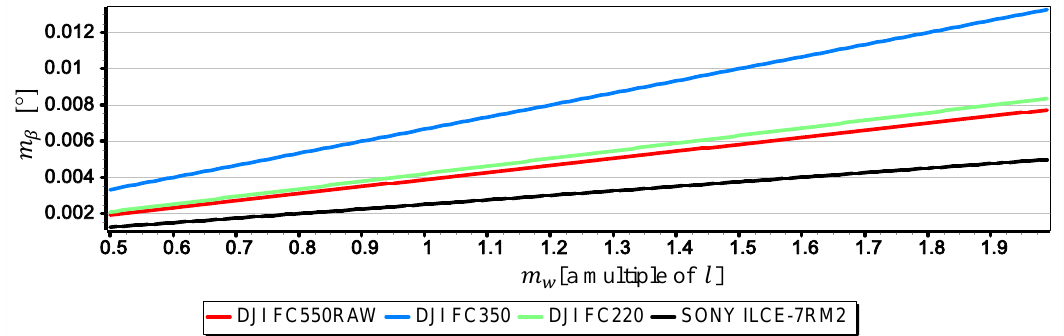
Figure 23. Mean error of measurement m β as a function of m w for β = 15 ◦ (only the second component Figure 23. Mean error of measurement 𝑚 𝛽 as a function of 𝑚 𝑤 for 𝛽 = 15° (only the second Figure 23. Mean error of measurement 𝑚 𝛽 as a function of 𝑚 𝑤 for 𝛽 = 15° (only the second of the Formula (3) was used in the component of the Formula (3) was used in the calculations). Figure 23. Mean error of measurement 𝑚 𝛽 as a function of 𝑚 𝑤 for 𝛽 = 15° (only the second component of the Formula (3) was used in the calculations). component of the Formula (3) was used in the calculations).